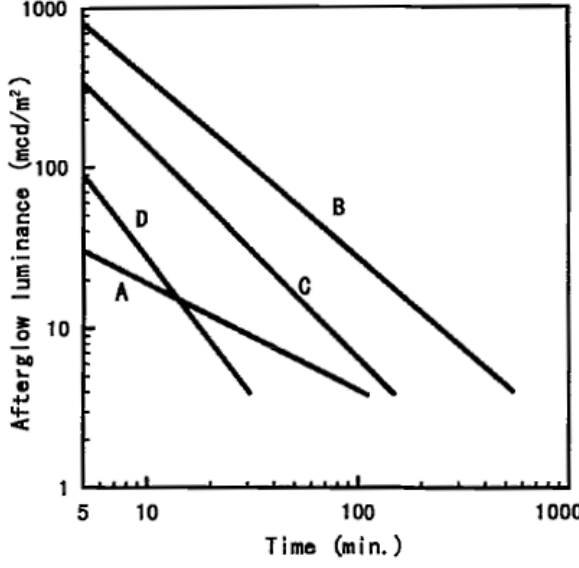
Figure 1. Comparison of afterglow characteristics measured after 10 min exposure to 200 lx of D light. A: SrAl O :Eu 2+ , B: SrAl O :Eu 2+ ,Dy 3+ , C: SrAl 65 2 4 2 4 ZnS:Cu,Co. (Reprinted with permission from [5]. Copyright 1996, The Electrochemical Society).